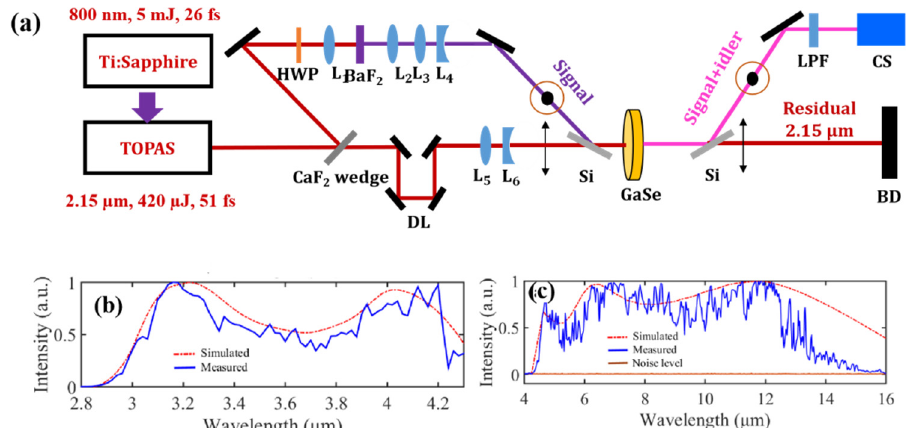
Figure 1. ( a ) The schematic of the GaSe-based MIR OPA. The pump, the generated supercontinuum, and the amplified MIR pulses are shown in maroon, purple, and pink, respectively. (HWP: half wave plate, DL: delay line, LPF: long pass filter, BD: beam dump, CS: characterization setup, and L1–L6 are CaF 2 lenses). The measured (solid blue, 20 nm resolution) and simulated (dashed red) spectra of the amplified signal ( b ) and the idler pulses ( c ). Reprinted with permission from [36].